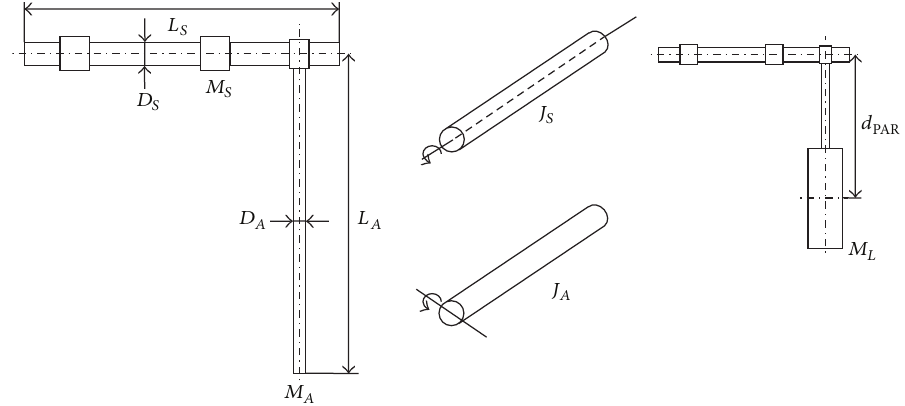
Figure 5: Arm and shaft dimensions for moment of inertia calculations (in the scheme, 𝐿 𝑆 is shaft length [m], 𝐷 𝑆 is shaft diameter [m], 𝑀 𝑆 is shaft mass [kg], 𝐿 𝐴 is arm length [m], 𝐷 𝐴 is arm diameter [m], 𝑀 𝐴 is arm mass [kg], 𝐽 𝑆 is shaft moment of inertia [kg ⋅ m 2 ], 𝐽 𝐴 is arm moment is parallel axis distance [m]). of inertia [kg ⋅ m 2 ], 𝑀 𝐿 is load weight [kg], and 𝑑 PAR